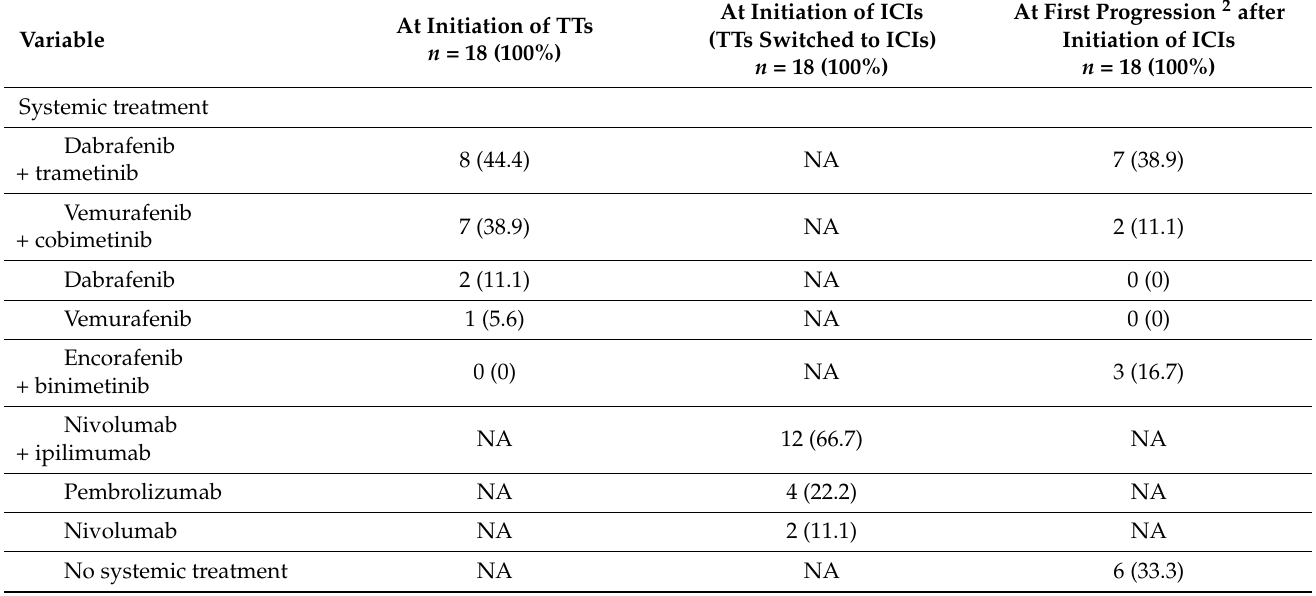
Detailed Description Table A6: Switching from TT to ICI